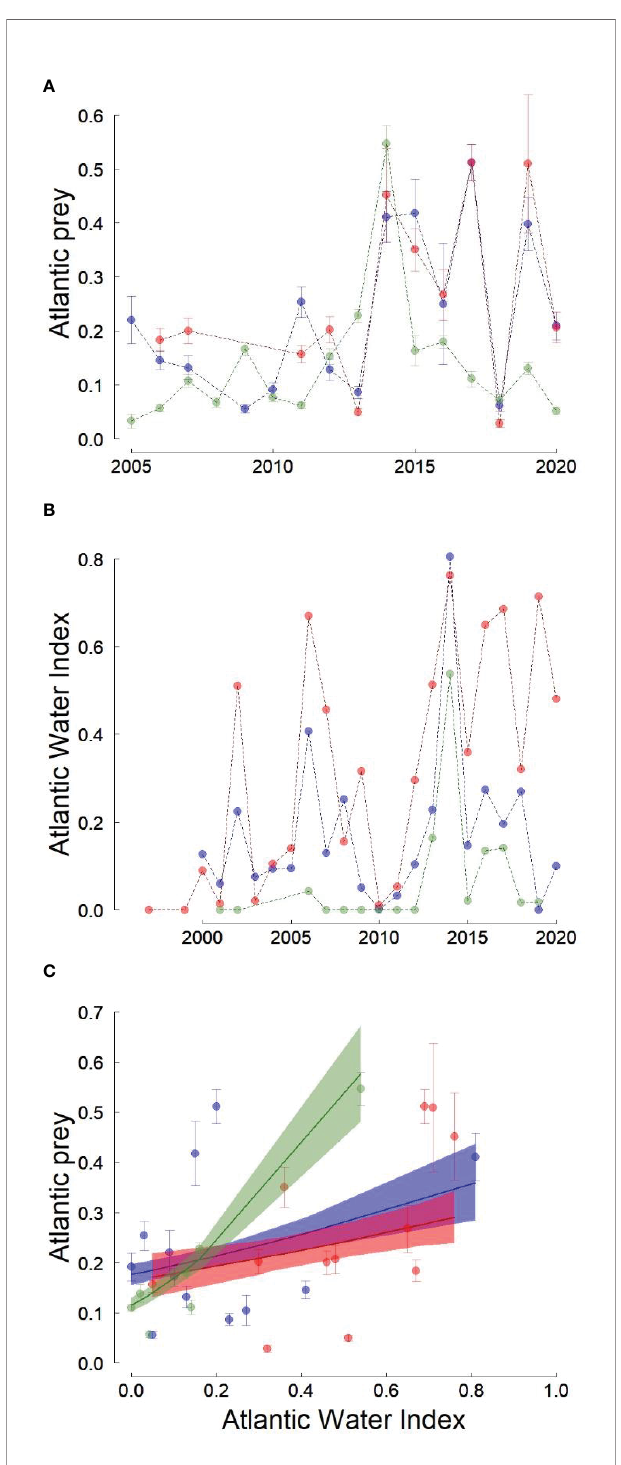
FIGURE 2 | Proportion of Atlantic prey in little auk chick diet (A) and Atlantic water Index (B) in three western Svalbard fjords (green: Hornsund, blue: Isfjorden, red: Kongsfjorden). (C) represents the relationships between the % Atlantic prey and the AWI and the lines are the predicted relations from beta regressions. The shaded areas represent bootstrapped 95% con fi dence intervals of the predicted values. Error bars represent the standard errors of the average proportions of Atlantic prey.